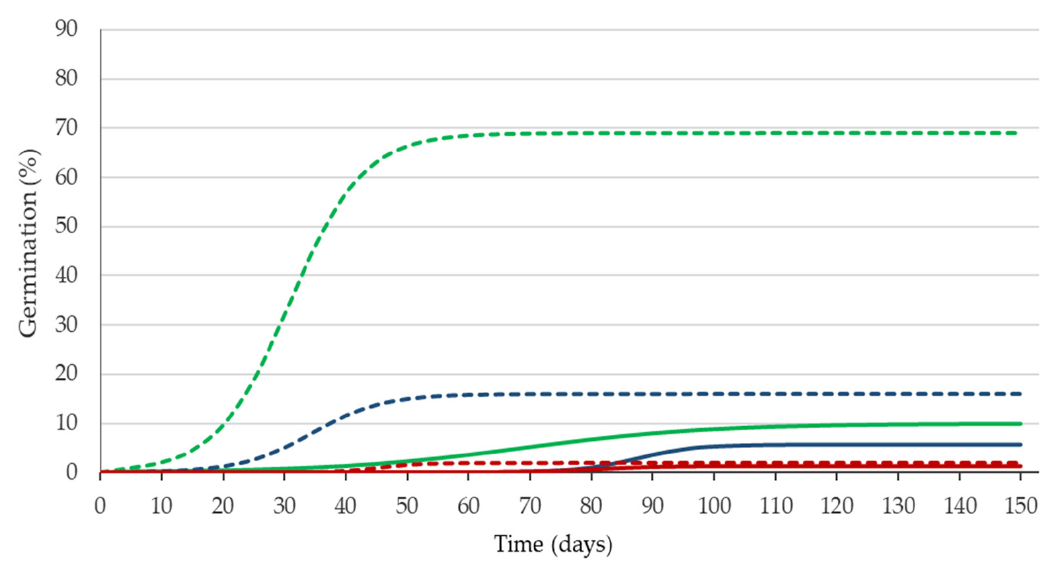
Figure 2. Logistic model fitted to the cumulative germination curves of caper seeds. Mean values for the combination of the type of seed (own produced (OS), type IV, and commercial (CS) seeds in green, blue and red, respectively) and substrate saturation solution (water in continuous lines and GA 3 solution in dashed lines).